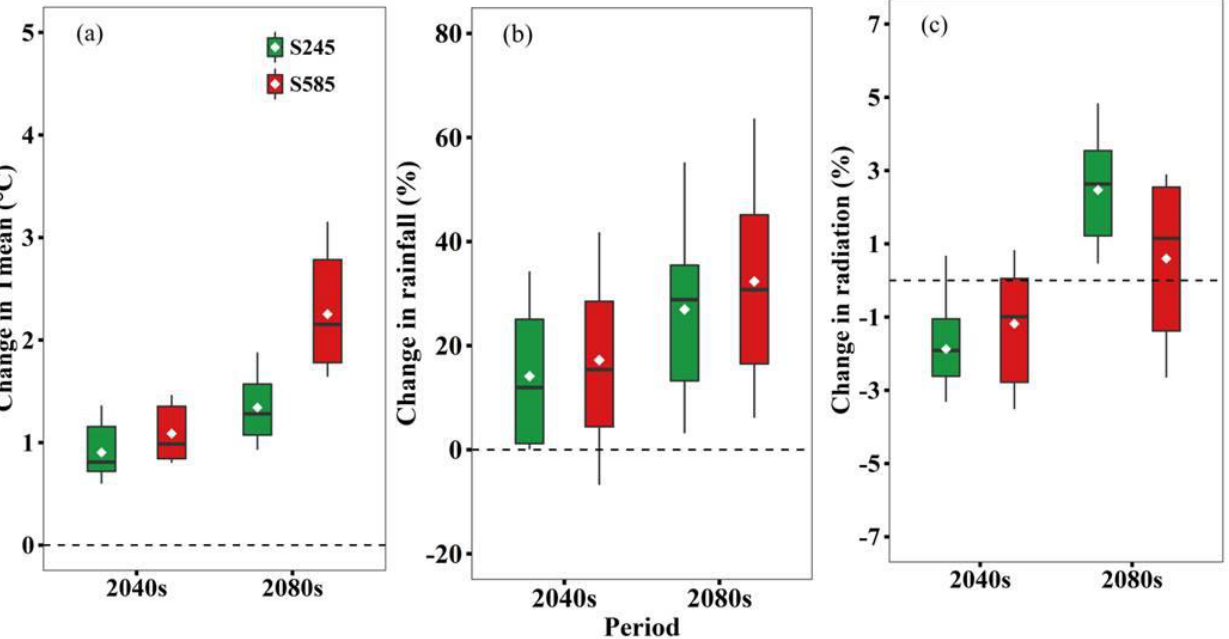
Figure 2. Projected changes in growing season average temperature (Tmean) ( a ), total rainfall ( b ), and total solar radiation ( c ) in 2030–2059 (2040s) and 2070–2099 (2080s) relative to the baseline (1961–2000) under SSP245 and SSP585 based on 21 GCMs. Box boundaries indicate the 25th and 75th percentiles across GCMs, and whiskers below and above the box denote the 10th and 90th percentiles. The black lines and dots inside the box indicate the multi-model median and mean,